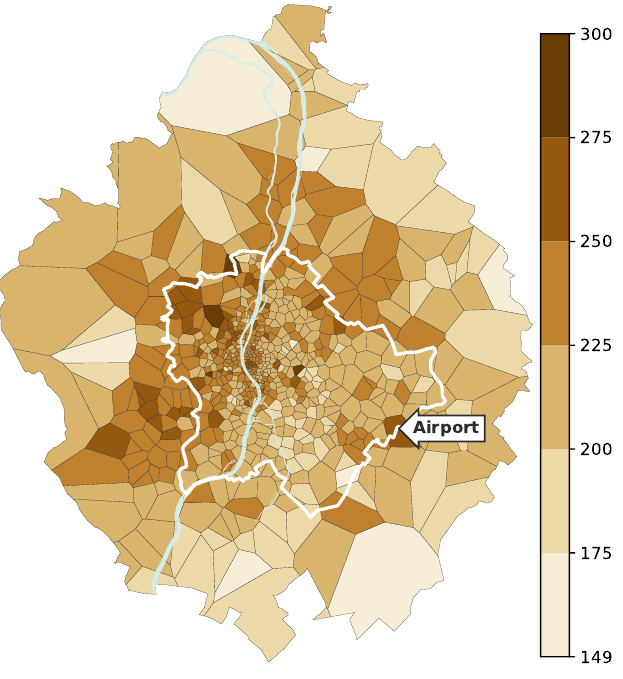
Figure 8. Average price (in EUR) of the mobile phones that generated the activity records in each site during the whole observation period (June